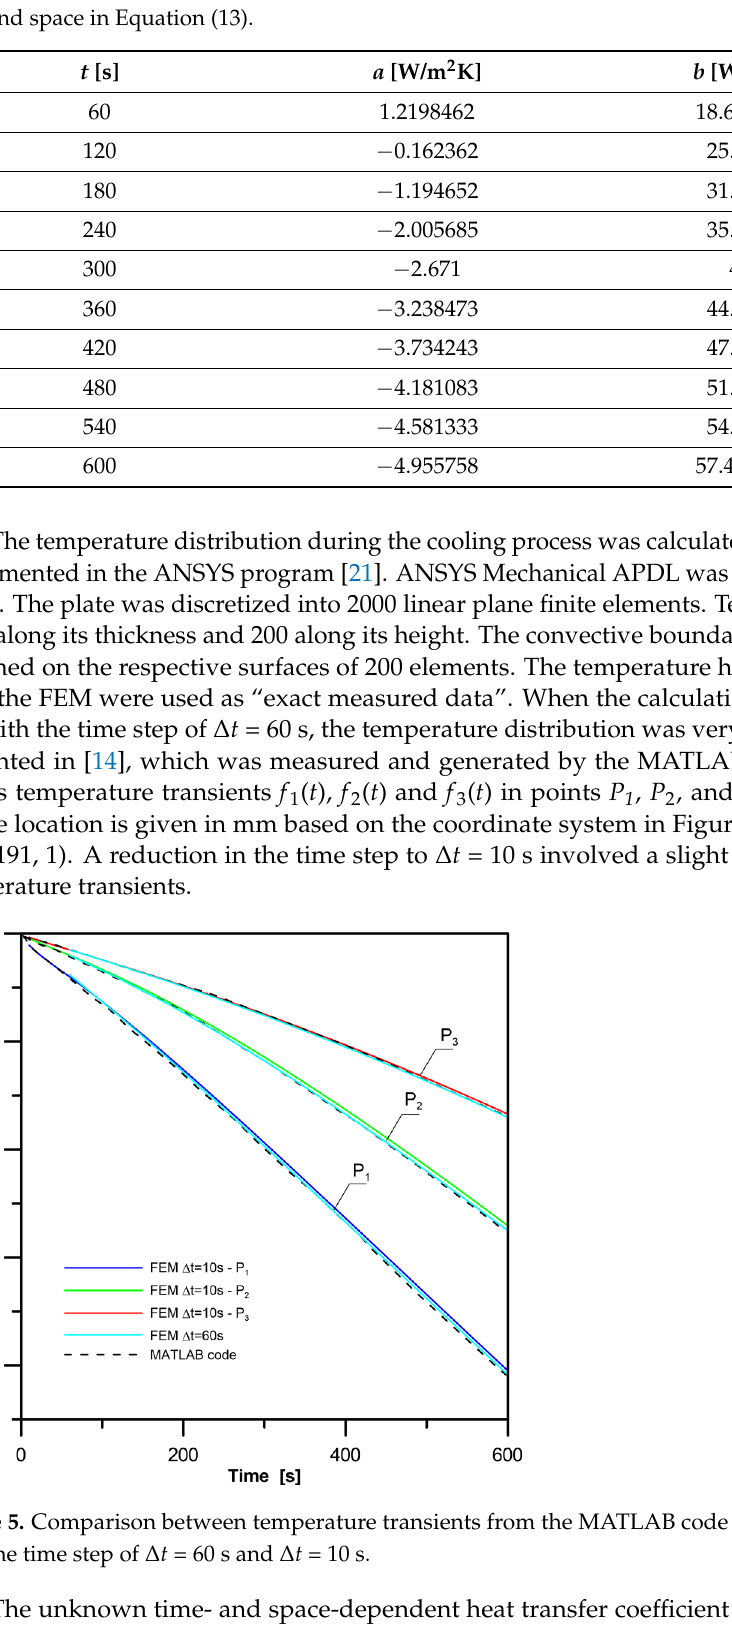
Figure 5. Comparison between temperature transients from the MATLAB code and from the FEM with the time step of Δ t = 60 s and Δ t = 10 s. with the time step of ∆ t = 60 s and ∆ t = 10